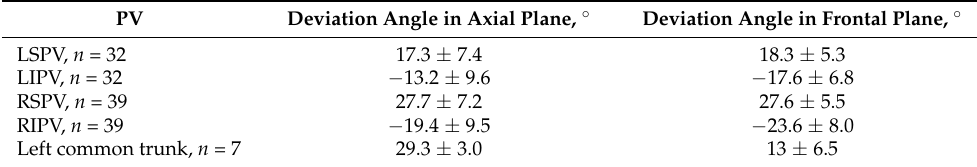
Table 4. Spatial orientation of PV in second generation